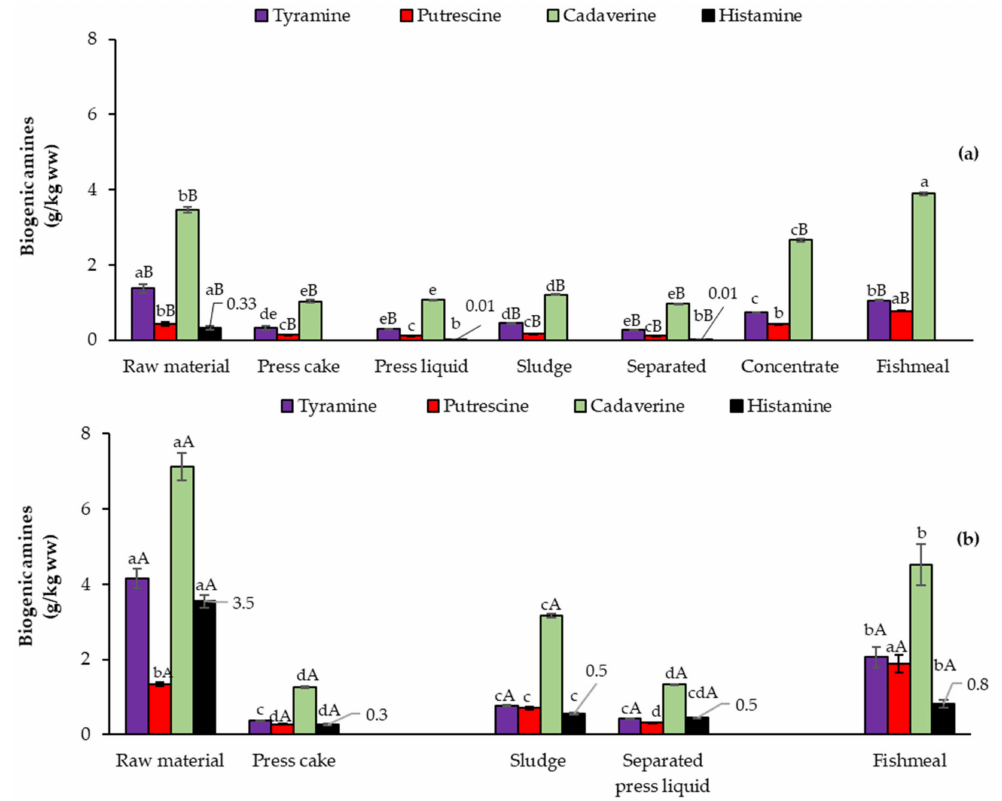
Figure 4. Biogenic amines (BA) (g/kg ww) obtained during fishmeal and oil processing from BW ( a ) and MHB ( b ). Within each BA type, lowercase letters indicate a significant difference between sampling locations, while uppercase letters show significant differences between raw materials at the same processing step. Statistical significance levels were set to p < 0.05 for all